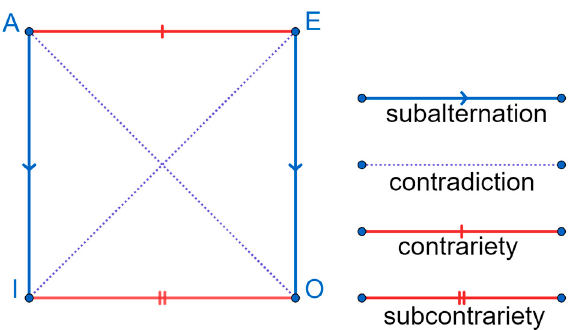
Figure 6. Square of Opposition, illustrating logical relations among propositions A, E, I, and O. Table 1. Traditional and Modal Interpretations of the Square of Opposition. Traditional Square Modal Square (Propositional)